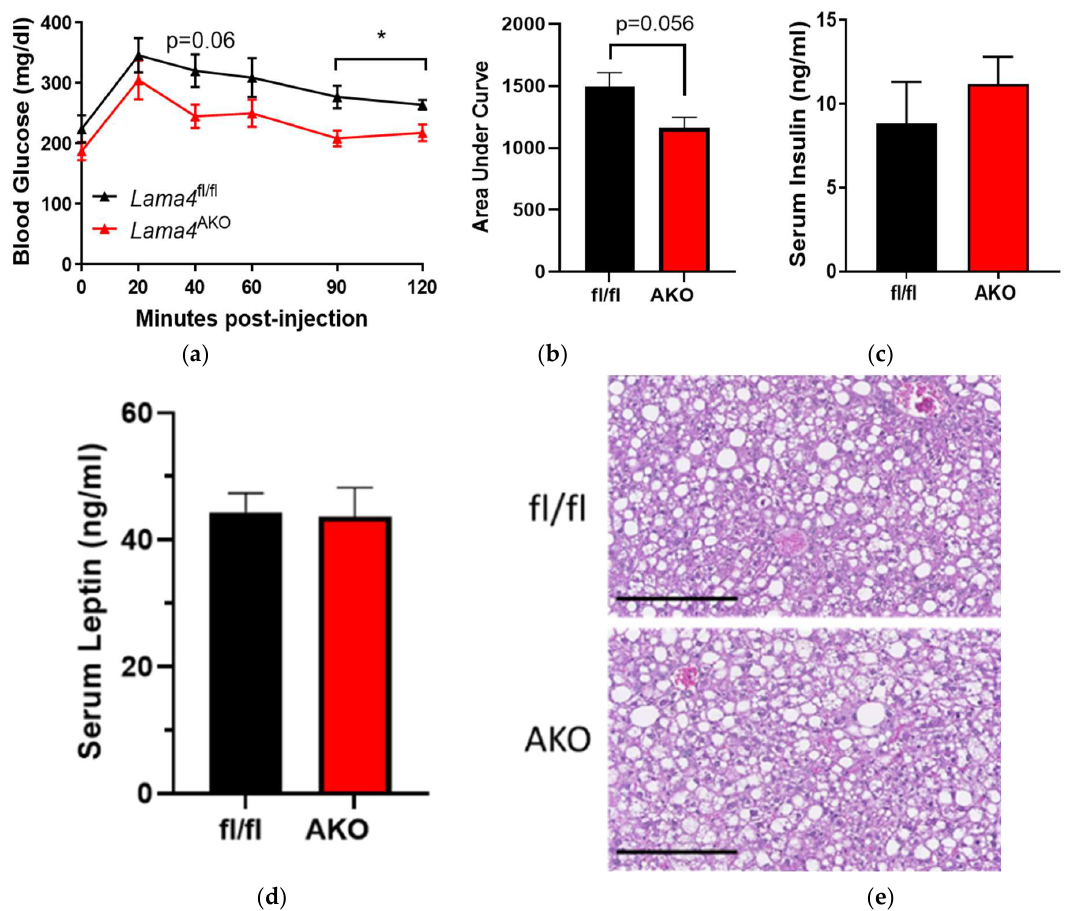
Figure 6. Glucose tolerance is improved, and postprandial insulin levels are unchanged in HFD-fed mice with adipocyte-specific LAMA4 deletion. Male Lama4 fl/fl and Lama4 AKO mice were provided HFD from 6–26 weeks of age. ( a ) Intraperitoneal glucose tolerance tests were performed after 18 weeks on diet ( n = 15–16 mice per genotype after a 4-h fast). ( b ) The area under curve calculated from ( a ). ( c ) Insulin levels and ( d ) leptin levels in serum from fed mice ( n = 6 per genotype) were measured by ELISA. ( e ) Representative images of H&E-stained liver sections ( n = 5–7 per group). * p < 0.05 between genotypes. Scale bars = 250 μm.